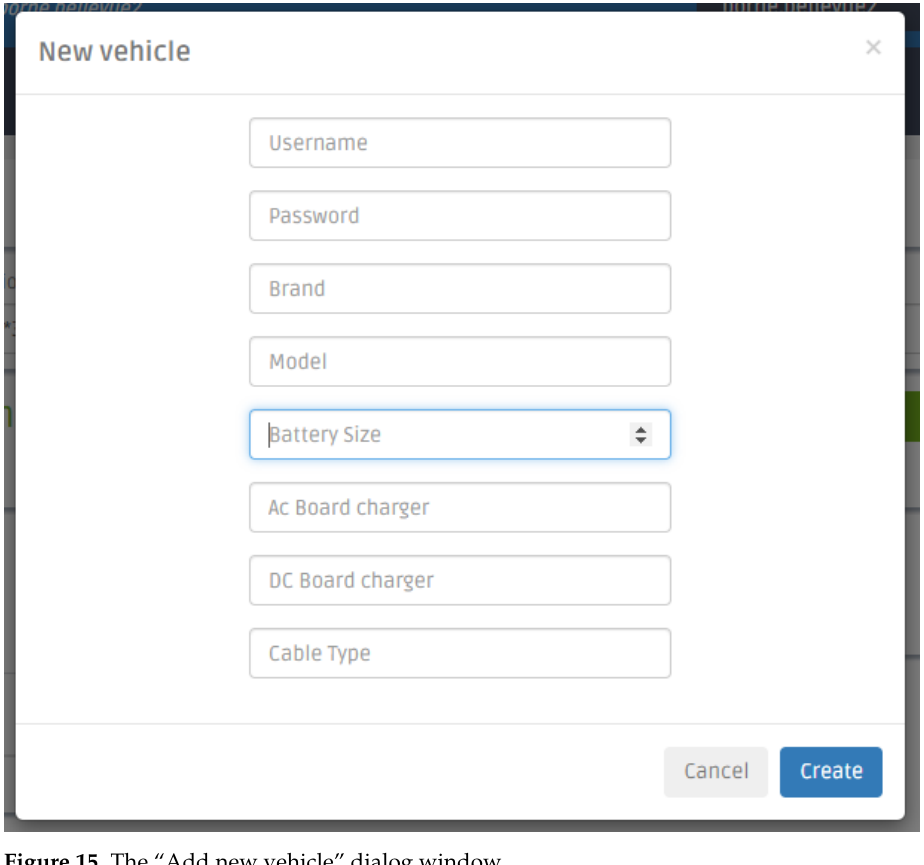
Figure 15. The “Add new vehicle” dialog window.